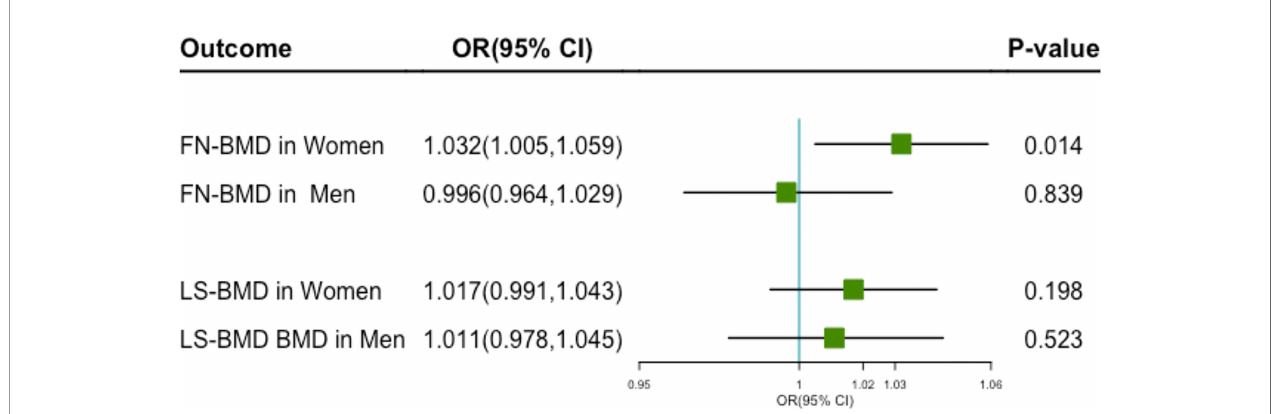
FIGURE 3 | The plot of the MR study used genetic instruments with FN-BMD and LS-MD in different genders. OR, odds ratio; CI, con fi dence interval; FN-BMD, femoral neck Bone Mineral Density; LS-MD, lumbar spine Bone Mineral Density.